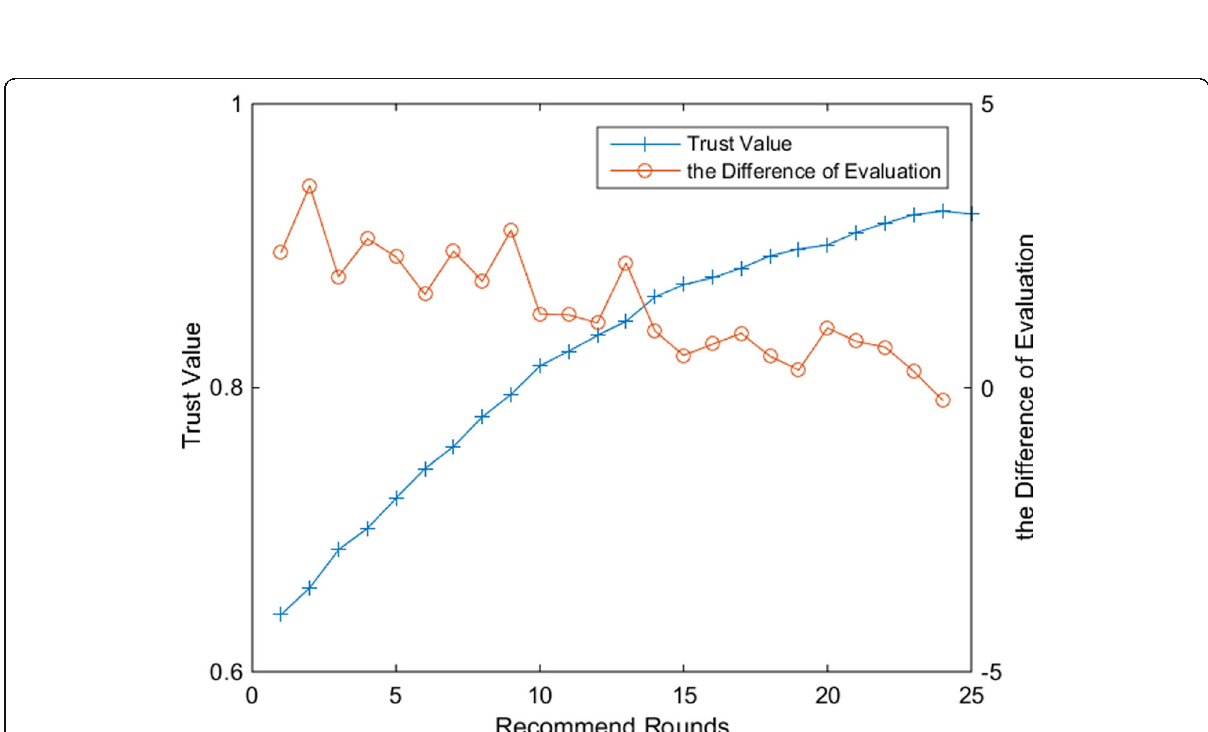
Fig. 8 Correlation graph of evaluation and trust (with LMS and η =